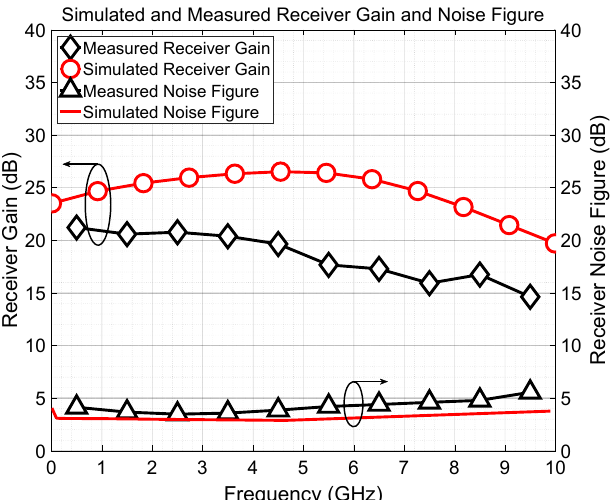
Figure 17. Simulated and measured receiver gain and NF.